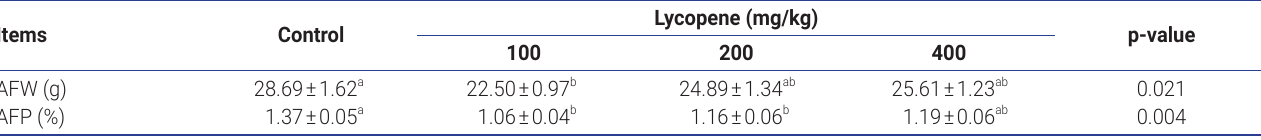
Table 4. Effects of lycopene on abdominal fat deposition of broiler chickens Items